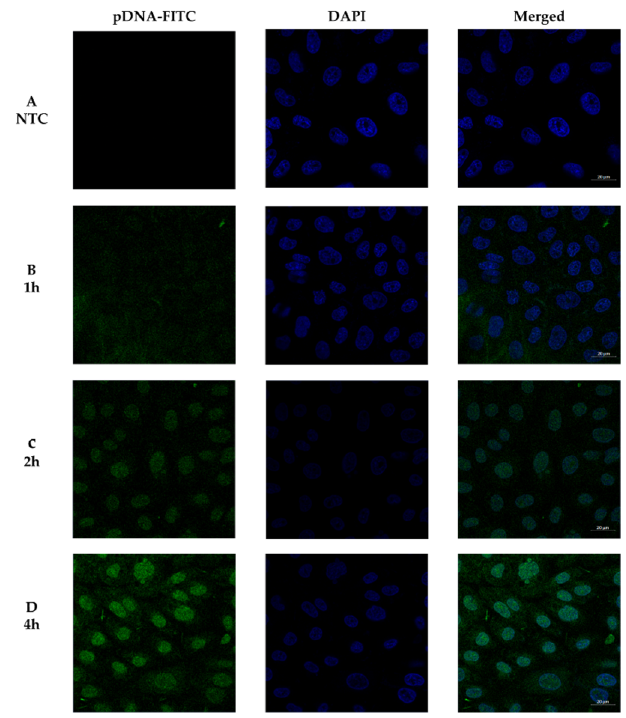
Figure 6. A fluorescence confocal microscopy evaluation of transfection ability and intracellular co-localization displayed by PAMAM G4-PTX/pDNA/PEI systems at 50:2:1 ratio. Nuclei are stained blue by DAPI and green represents the pDNA stained with FITC. (A) non-transfected cells; (B) 1 h, (C) 2 h and (D) 4 h of cellular transfection. Scale bar = 20 μ m.